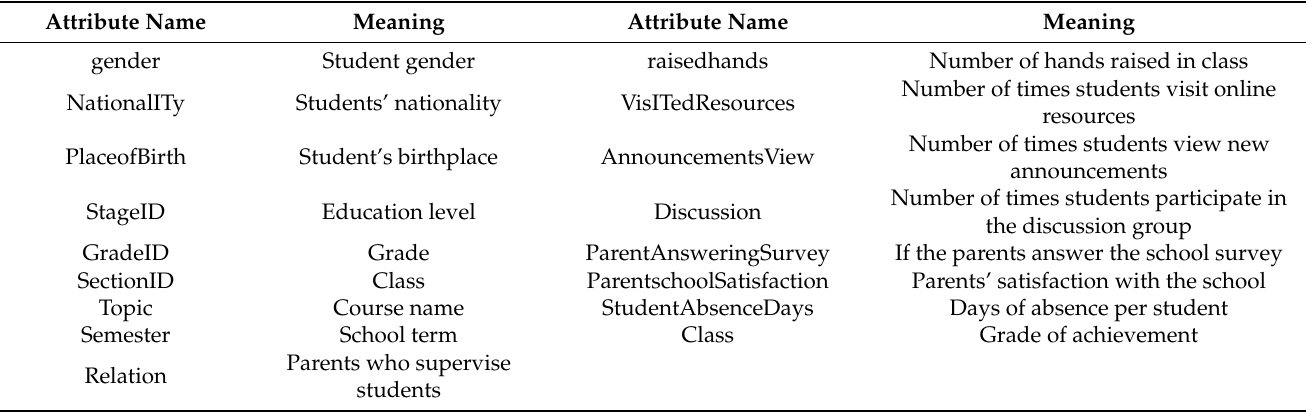
Table 1. Data set attribute name and